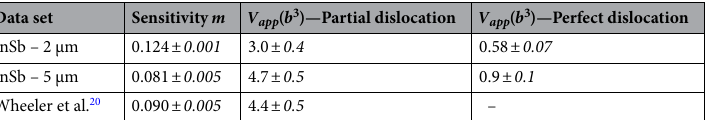
Table 1. Sensitivity m and activation volume for 2 µm and 5 µm micro-pillars compared to Wheeler et al. data.